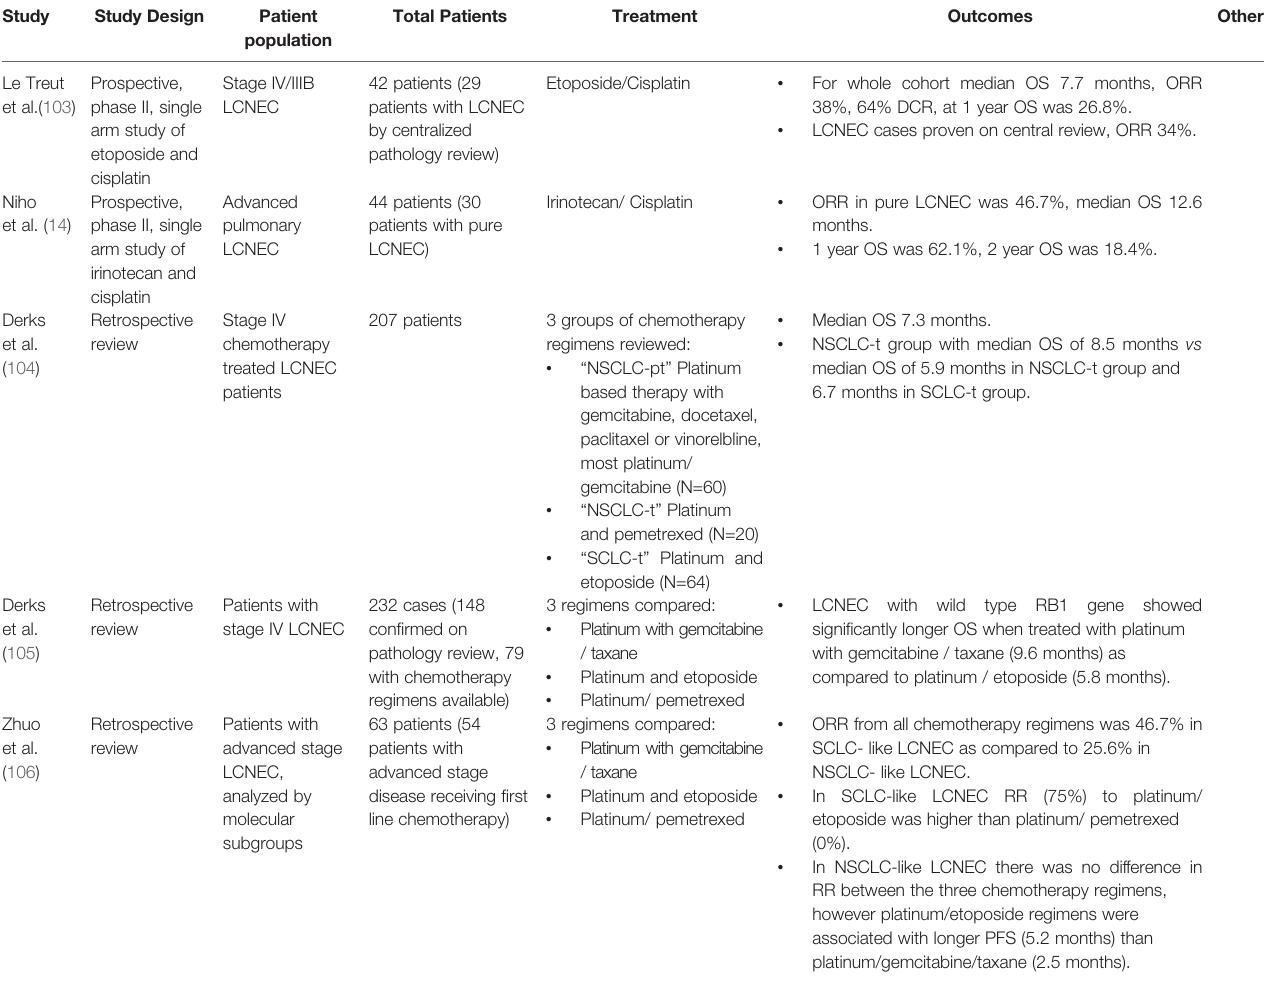
TABLE 7 | Key Papers Describing First Line Therapy in Metastatic Pulmonary